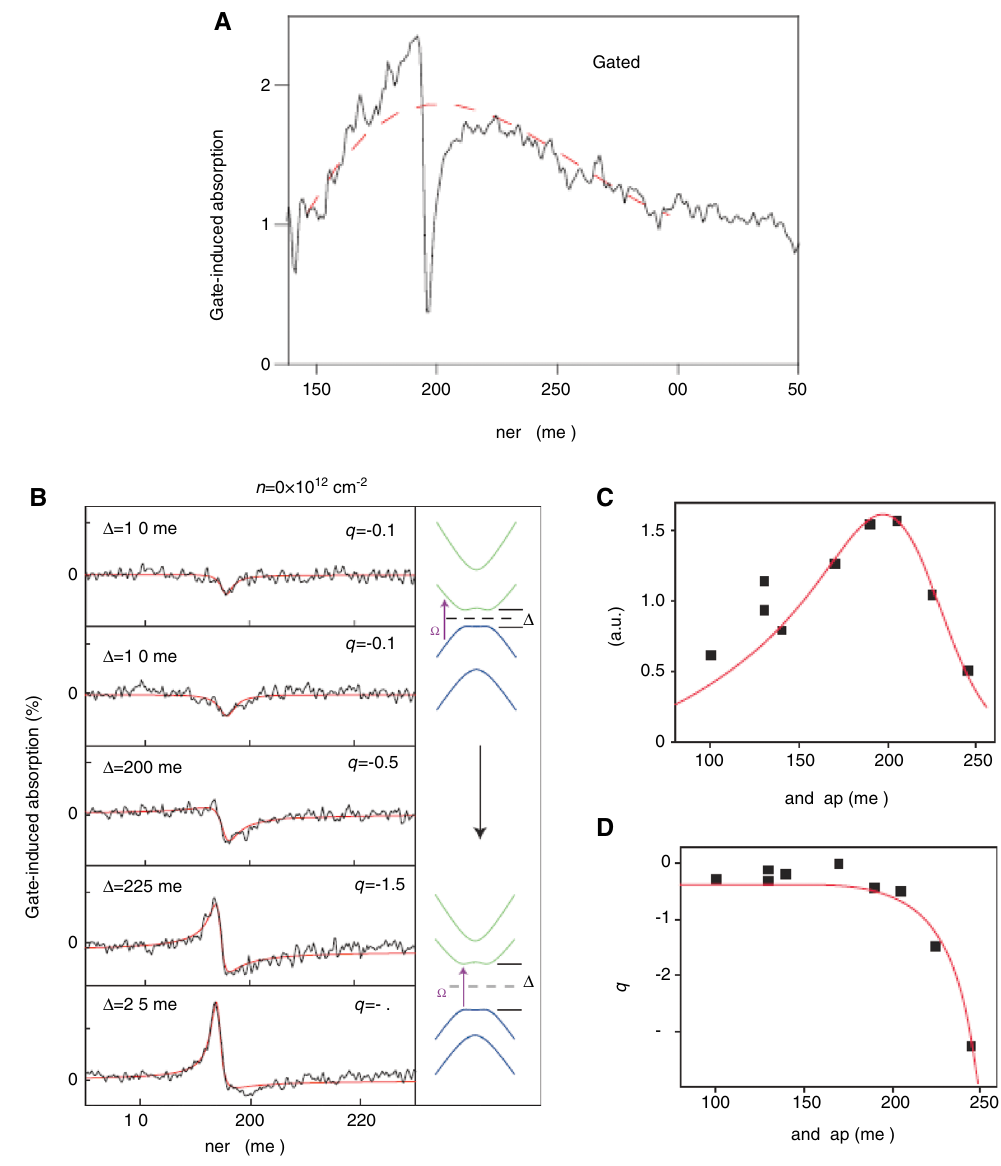
Figure 5 Tunable Fano resonance in dual-gated bilayer graphene. (A) Absorption spectrum in the phonon region with zero doping and a band gap of 190 meV. The red dashed curve is the band-gap excitonic absorption profile. (B) Phonon spectra for various gapped bilayer graphene. The band gap ranges from 130 meV to 245 meV. The net carrier density is kept at zero. The red curves are fits based on Fano model. (C) The phonon amplitude as a function of the band gap. (D) The Fano parameter q as a function of the band gap (A–D adapted with permission from [30], Copyright 2010 Nature Publishing